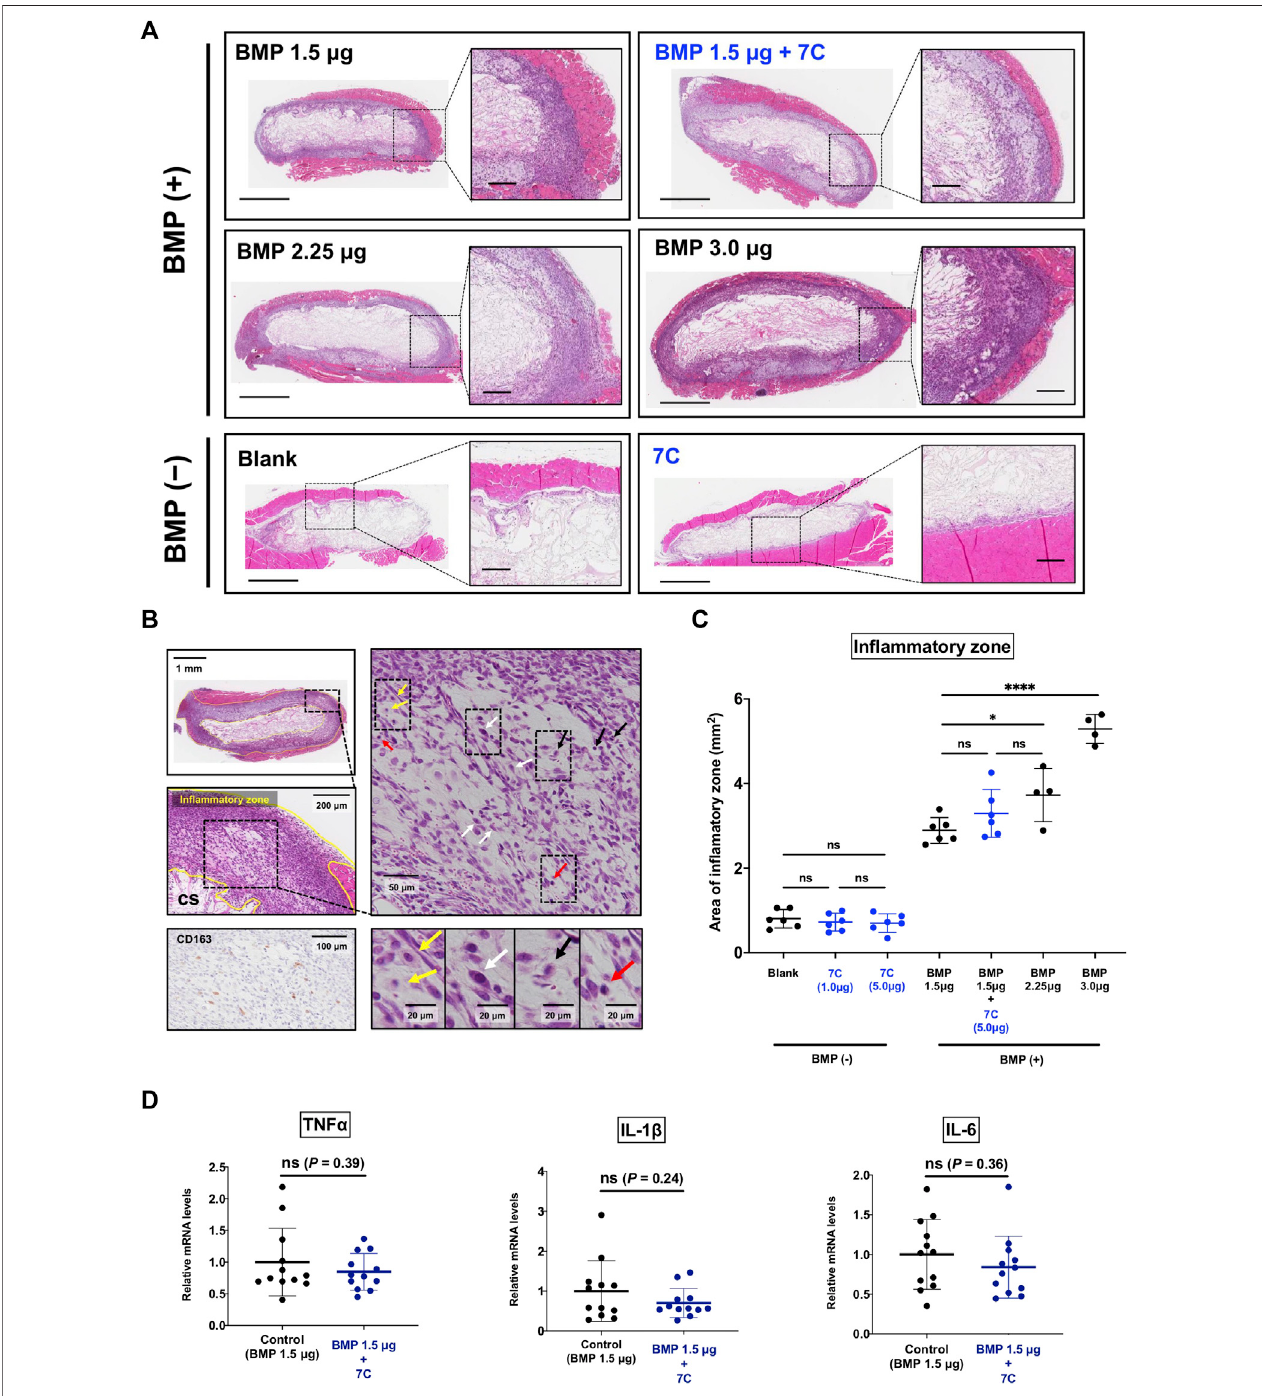
FIGURE 5 | Effect of 7C on in fl ammatory response. (A) Representative microscopic images of the in fl ammatory zone stained with H&E in the pellets; the in fl ammatory zone expanded depending on the BMP amount, and the pellets without BMP (containing only blank-NP or 7C-NP) showed a small in fl ammatory zone. Whole view, scale bar = 1 mm; magni fi ed view, scale bar = 200 μ m. (B) Histological analysis of the in fl ammatory zone. The tissue (in fl ammatory zone) surrounding the collagen sponge (CS) was in fi ltrated with in fl ammatory cells such as macrophages (yellow arrow), fi broblasts (white arrow), leukocytes (black arrow) and lymphocytes(redarrow).ImmunohistochemistryforCD163thatispositiveinhistiocytes. (C) Theanalysisofthein fl ammatoryzone.* p < 0.05,**** p < 0.0001,andns,not signi fi cant. (D) ThemRNAexpressionlevelsofin fl ammatorycytokines(TNF- α ,IL1- β ,andIL-6)intheBMP-2(1.5 μ g)pelletswithorwithout7C-NPs. n =12pergroup.ns, not signi fi cant.